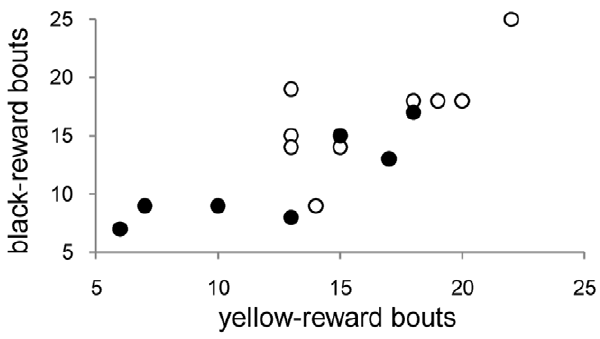
Figure 5. Relationship between bouts required to complete the learning task when yellow versus black curtains were associ- ated with a food reward. (Open circles=LO diet birds; closed circles=HI diet birds. Means 6 S.E. for black reward: LO –16.67 6 1.47 (N=9); HI—11.14 6 1.45 (N=7).)